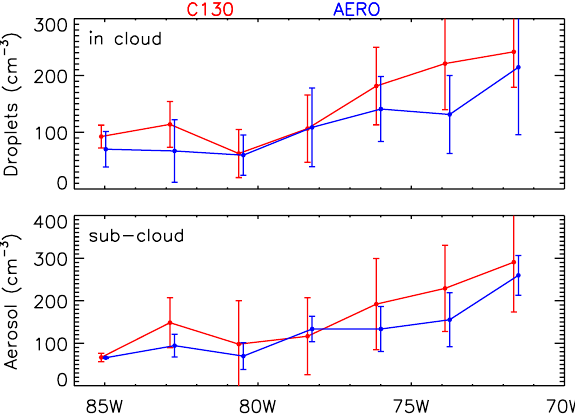
Fig. 3. Droplet number concentrations in the cloud layer and aerosol number concentrations in the sub-cloud layer observed on the C-130 aircraft (red) and predicted by the AERO simulation (blue). The aerosol size range is 0.156–2.69µm in diameter for observations and 0.156–2.5µm for the model. The error bar represents ± 1 σ